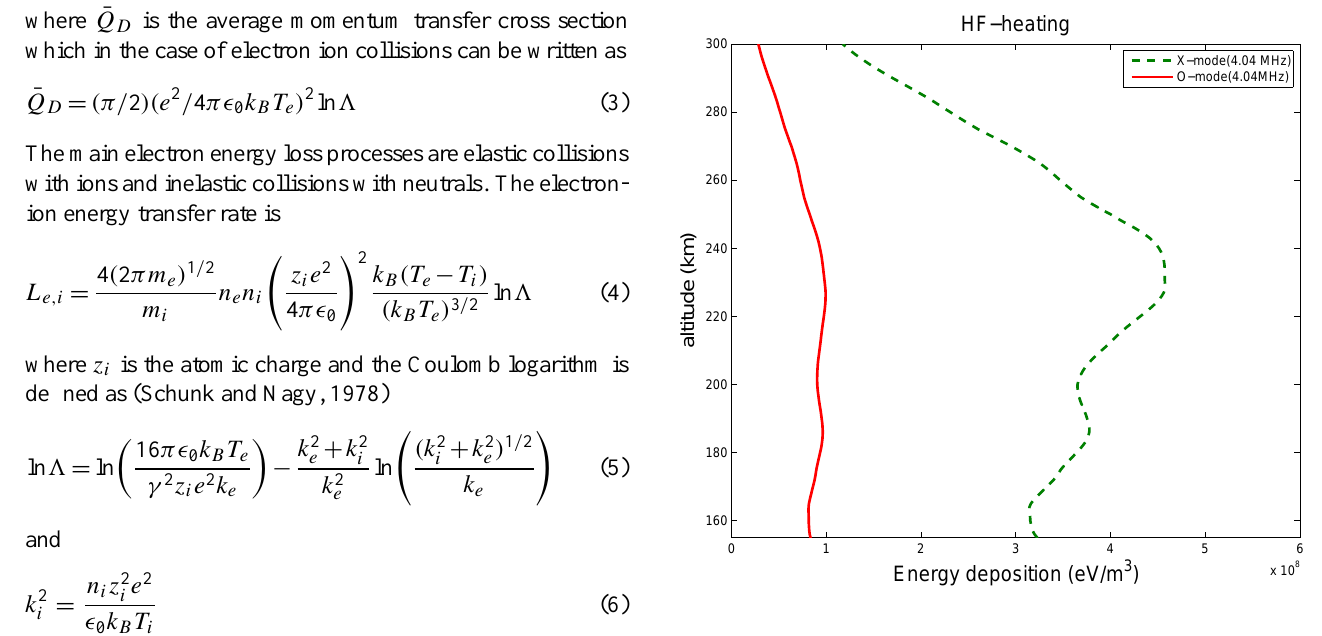
Fig. 4. Profile of X-mode energy deposition from heater used for solution of the energy equation for October 17. Calculated values for O-mode for the same frequency is shown as a